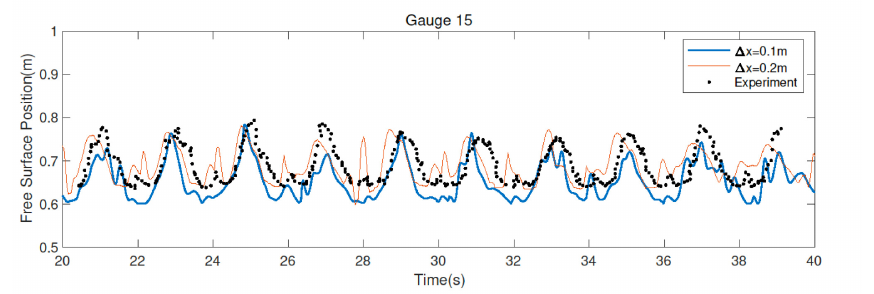
Figure 6. Examination of the surface elevation at WG15 using the two finest